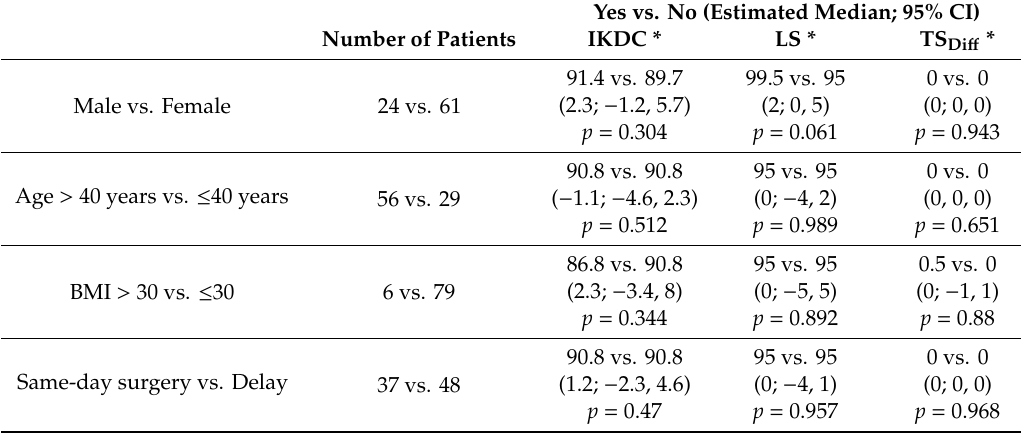
Table 2. No significant impact of gender, age, BMI and delay in surgery on median postoperative functional outcome scores. * Three patients who underwent revision surgery were excluded. Estimated medians of di ff erences and 95% CI were calculated with the Hodges–Lehmann estimator. p -value was calculated with the Mann–Whitney U